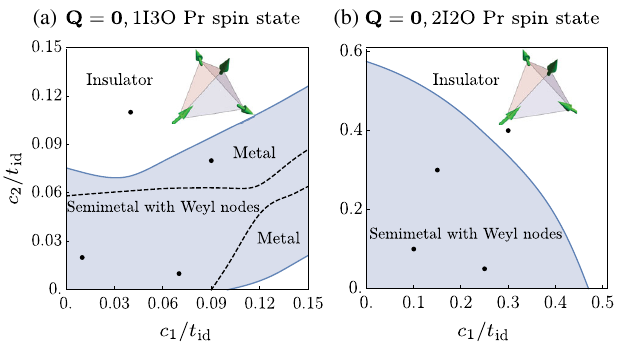
FIG. 7. Phase diagram for the Ir band structure in the parameter space of the f - d exchange couplings for different Pr magnetic states from Fig. 5(a). The bold dots in the plots are the parameter choices for Fig. is applied along the (111) direction, and there it does not bring different Ir band structures under this approximation.